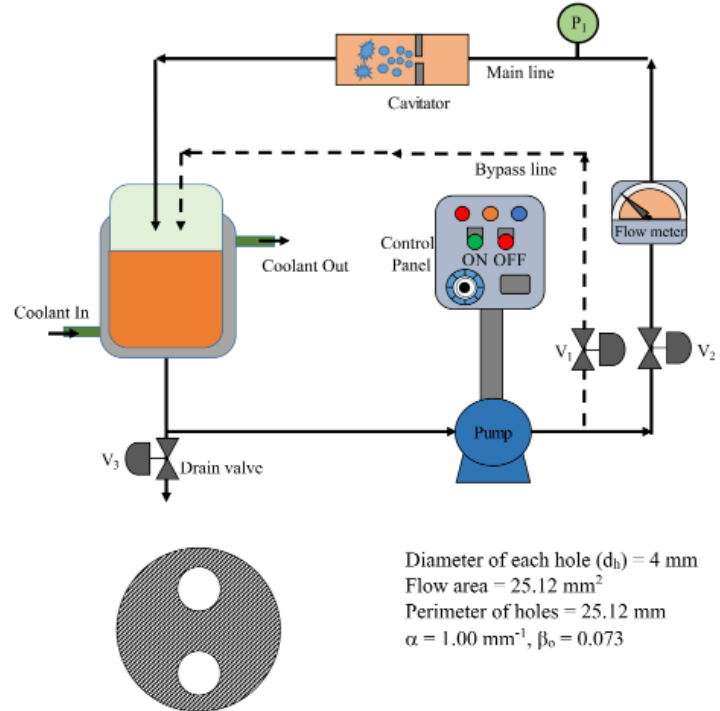
Figure 2. Schematic representation of the HC reactor for the oxidative degradation of SDZ. Reprinted with permission from [40].